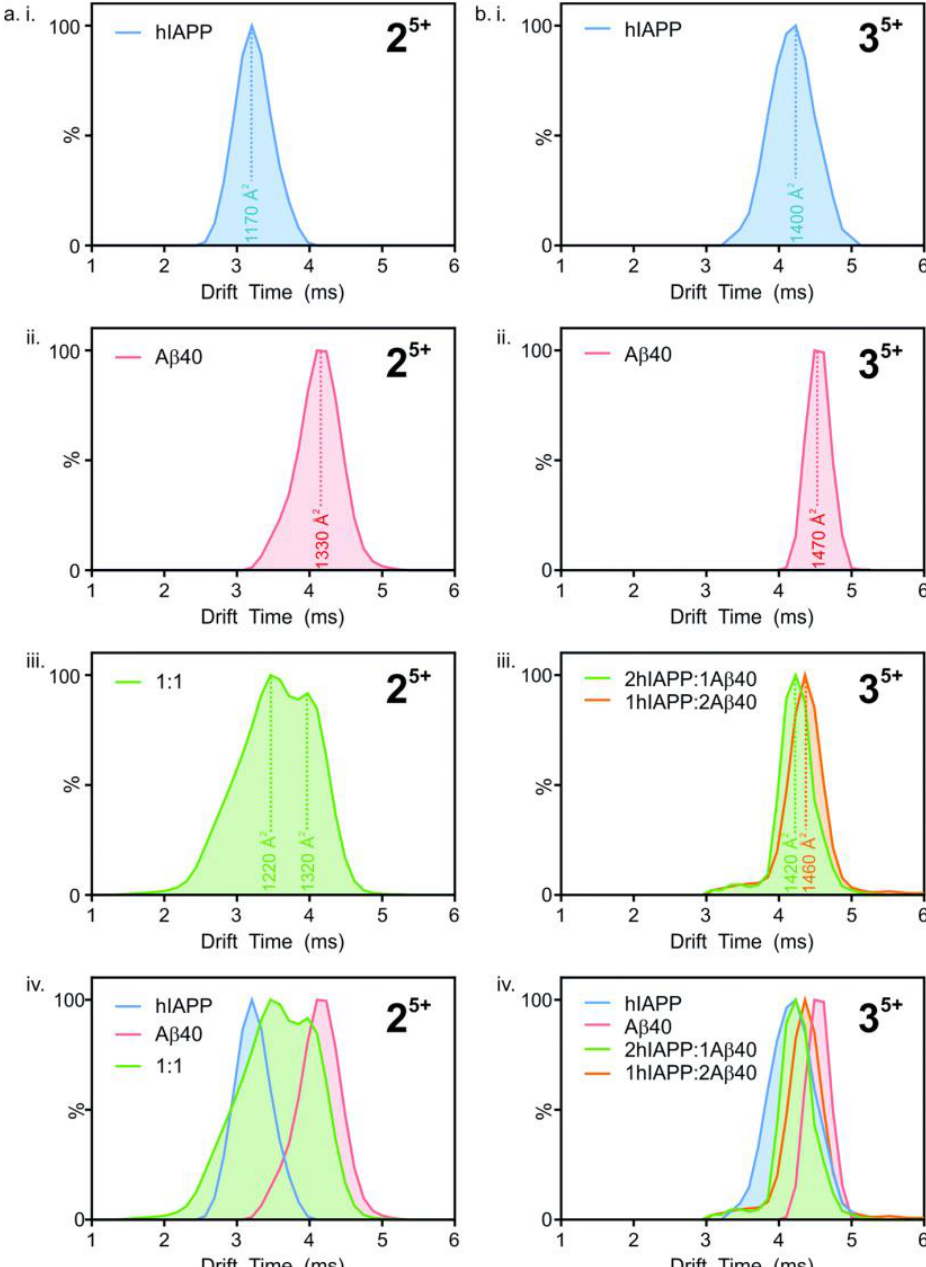
Figure 18. Collisional cross-section areas for dimers ( left ) and trimers ( right ) of Aβ and hIAPP at different molar ratios. Adapted from Young et al. [116]. Licensed under a Creative Commons Attribution (CC BY)